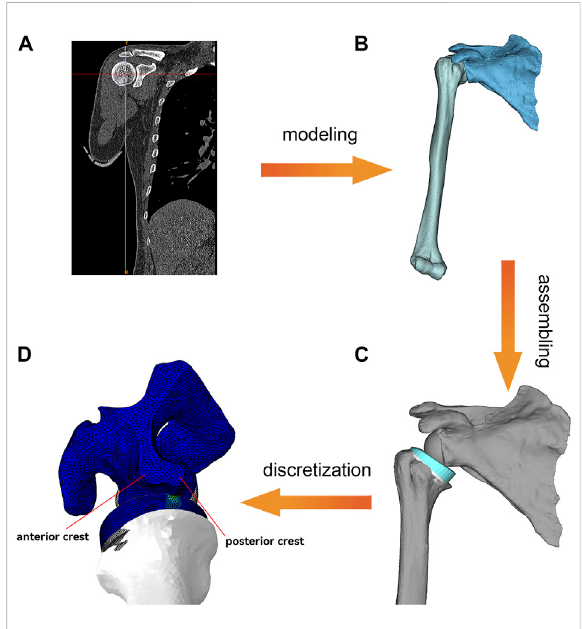
FIGURE 2 Overview of the FEA process. (A) , Shoulder CT data processing. (B) , Generation of scapula and humerus 3D models. (C) , Bone model and prosthesis model assembly and Meshing. (D) , Dynamic FEA. The lower border of the scapula is divided into a fl at anterior crest and a narrow posterior